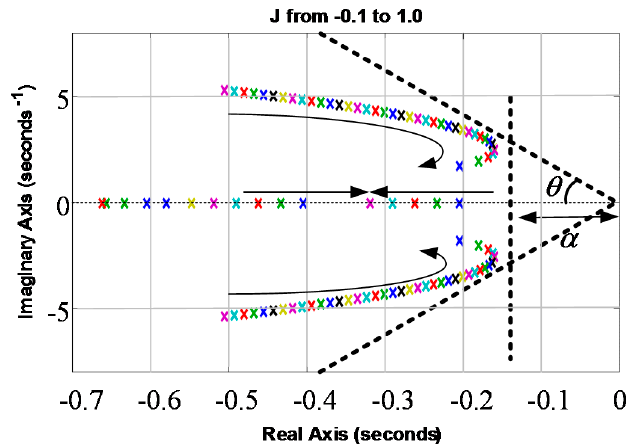
Figure 10. The root locus of this test system with the J from − 0.1 to 1.0.